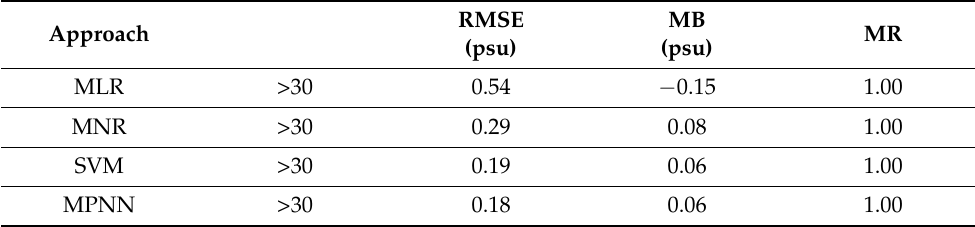
Table 8. Model comparison in independent validation of cruise